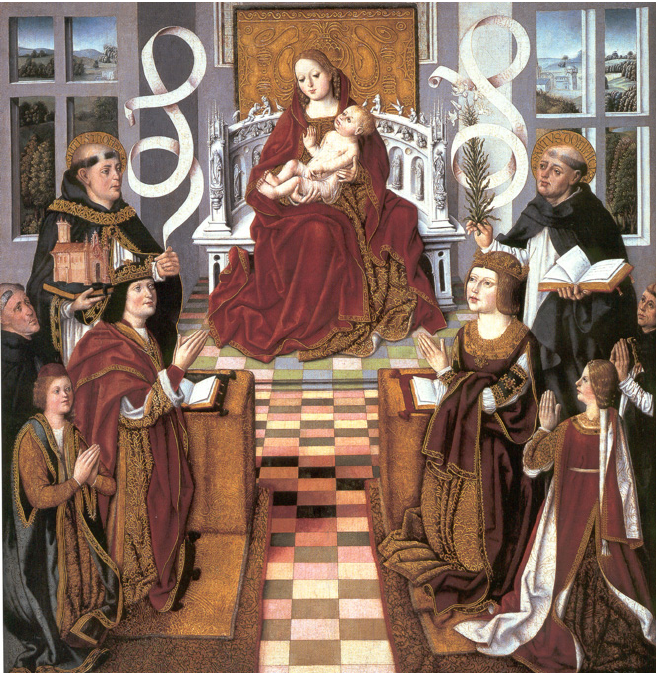
Figure 5. Virgen de los Reyes Católicos . c. 1490. Published by Bango, I. Dir.; Maravillas , vol. II, p. 184.